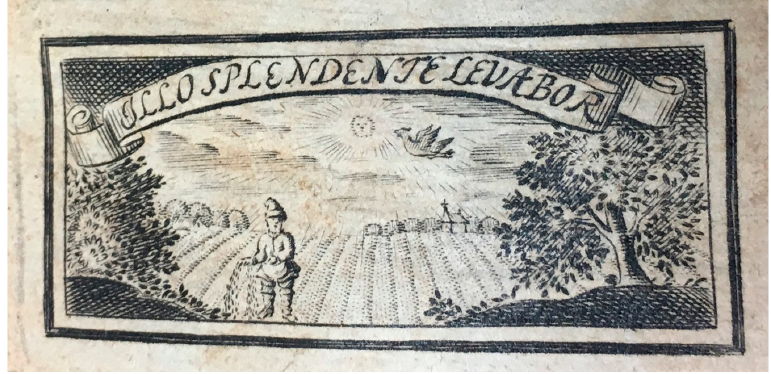
Figure 3. A 1722 version of the seal (Henckel von Donnersmark 1722). Erdmann Heinrich Henckel von